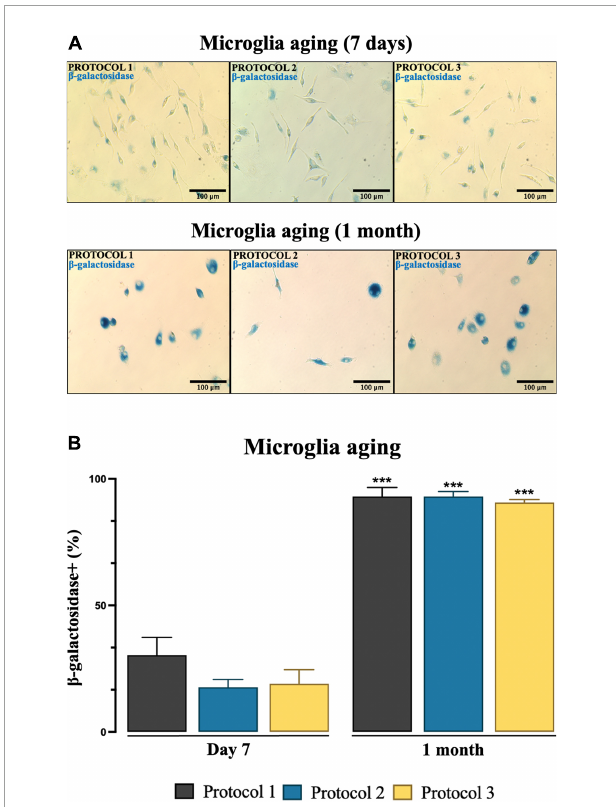
FIGURE11 Estimation of microglia senescence over an extended period of time. (A) Representative images of microglia showing SA- β -gal activity (blue) from different isolation protocols. Images were taken under a light microscope at 20x magnification. Scale bar: 100 µ m. (B) SA- β -gal-positive cells were counted and results were expressed as mean ± SEM; *** p < 0.001, compared to the day 7